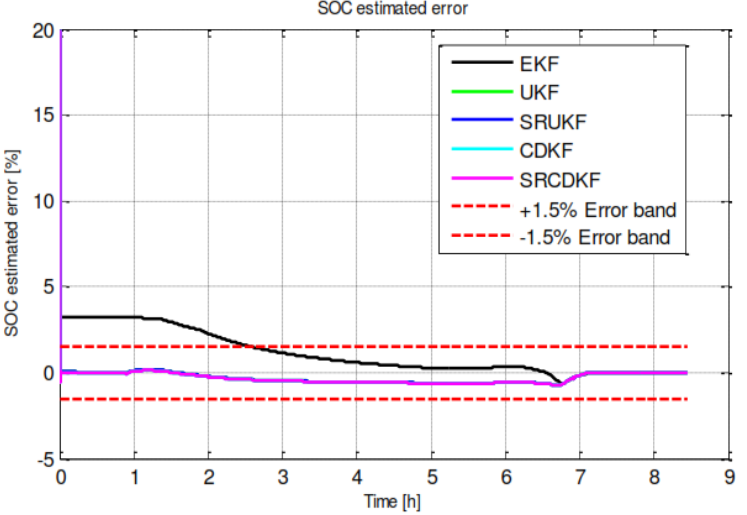
Figure 14. SOC estimated error of model 2 for EKF, UKF, SRUKF, CDKF, and SRCDKF.